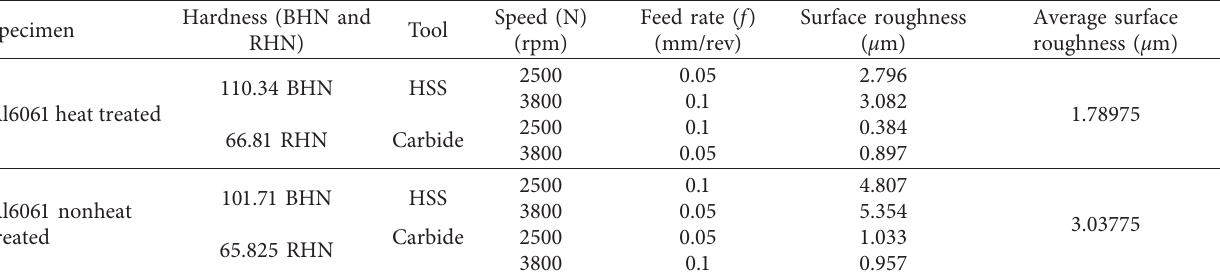
Figure 3: (a) Measurements of Ra on machined slots with Mitutoyo surface roughness tester. (b) Hardness measurement in the Rockwell hardness setup. Table 3: Graphical observations of CNC milling outcomes.